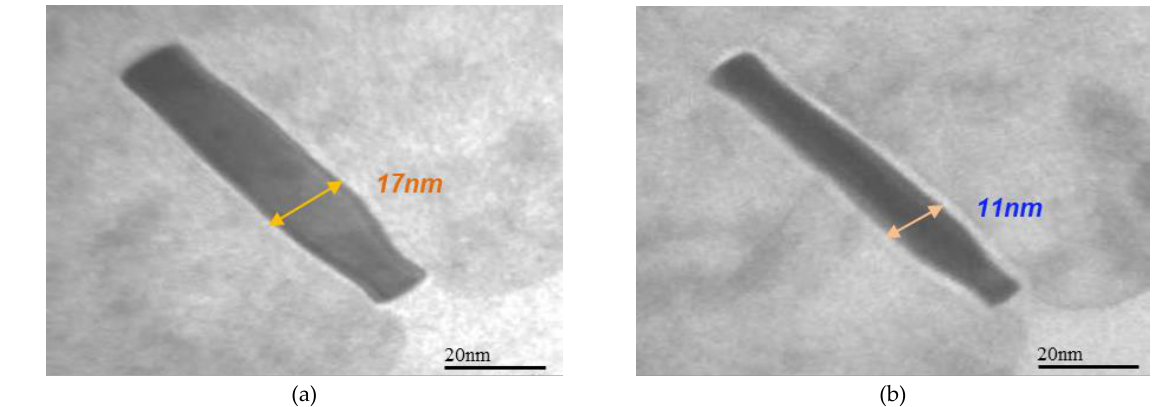
Figure 5. TEM photos for single Si-fin under exposure energy: ( a ) 28 mJ and ( b ) 31 mJ.